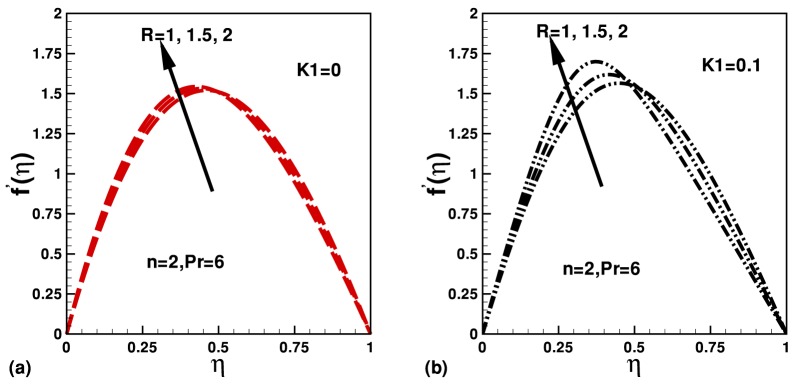
Effects ofon dimensionless velocity profile for different values of Reynolds number.